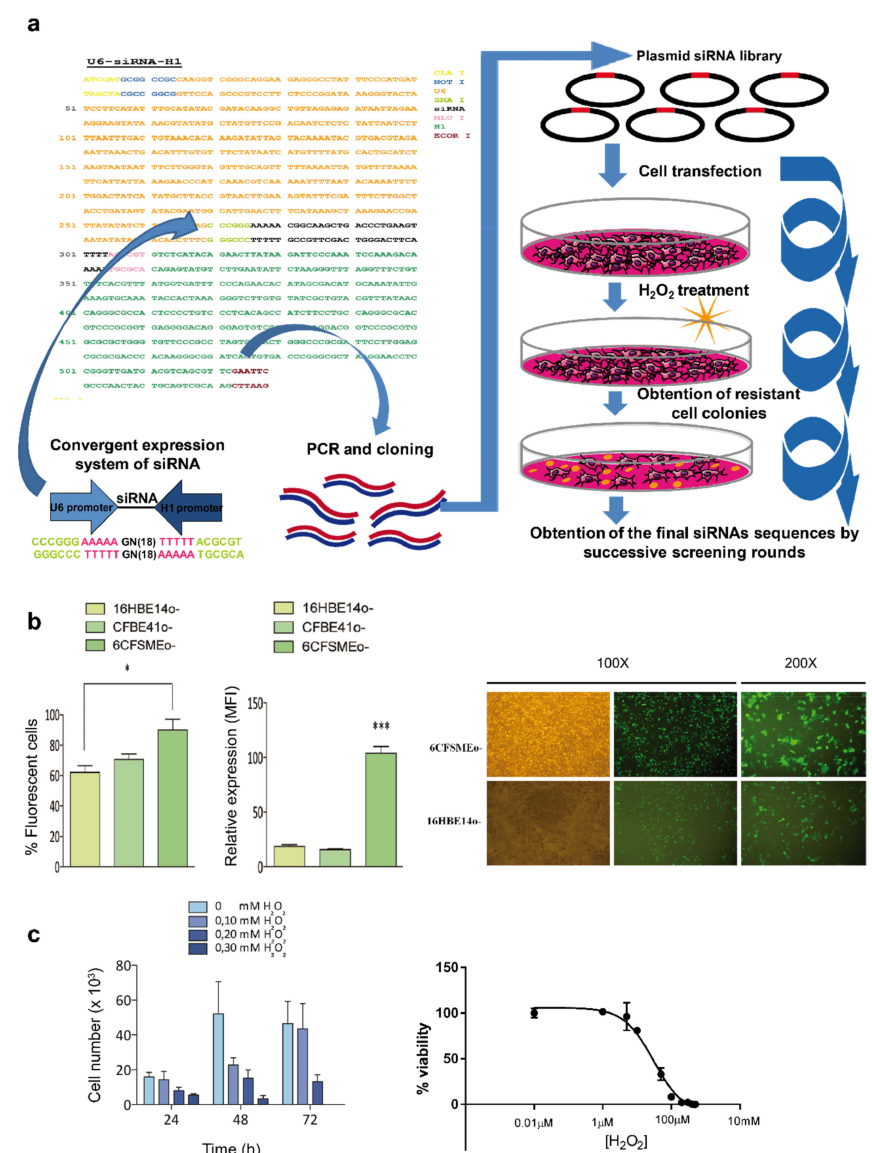
Figure 2. Outline of randomized siRNA library cloning, epithelial cell introduction, and selection of oxidative stress-resistant colonies. ( a ) Schematic representation of the cloning and transfection steps used to obtain the 181 final siRNA sequences. First, a construction containing a randomized siRNA library within a convergent expression cassette was cloned into the pCI-neo vector. The convergent expression system was optimized to express the siRNAs using two opposite promoters. Furthermore, the siRNA library within the convergent expression system was transfected and expressed in CF submucosal gland cells. These cells were subjected to H 2 O 2 -mediated stress and different resistant colonies arose. Successive screening rounds were performed until a final collection of 181 siRNA sequences capable to confer oxidative stress resistance were obtained. ( b ) Optimization of transfection in human airway epithelial cells. Transfection efficiency of human airway epithelial cells. Left: 1 × 10 6 cells were transfected with 3 µ g of pEGFP-N1 and the percentage of fluorescent cells and median fluorescence intensity (MFI) were analyzed by flow cytometry. Data are expressed as means ± SD. n = 3 with 5 technical replicates/each. * p < 0.05; *** p < 0.001 compared to the control. 16HBE14o-, bronchial epithelial cells; CFBE41o-, bronchial epithelial cells homozygous for the CFTR F508del mutation; 6CFMEo-, compound heterozygous submucosal gland epithelial cells for the CFTR F508del, and Q2X mutations. Right: representative phase contrast and fluorescence microscopy images comparing the transfection efficiencies from 6CFSMEo- and 16HBE14o- cells. ( c ) Assessment of oxidative stress sensitivity in 6CFSMEo- airway epithelial cells. 6CFSMEo- viable cell number trough toxicity assays after exposure to H 2 O 2 . n = 4. Left: optimization of the necessary dose of H 2 O 2 to obtain 90%–100% cell death in 6CFSMEo- cells. At 24 h after seeding 1 × 10 6 cells per plate, the medium was changed to fresh medium containing different H 2 O 2 concentrations. Cells were counted at 24, 48, and 72 h. Right: Toxicity curve of H 2 O 2 in 6CFSMEo- cells. The concentration range used in the study was 0–500 µ